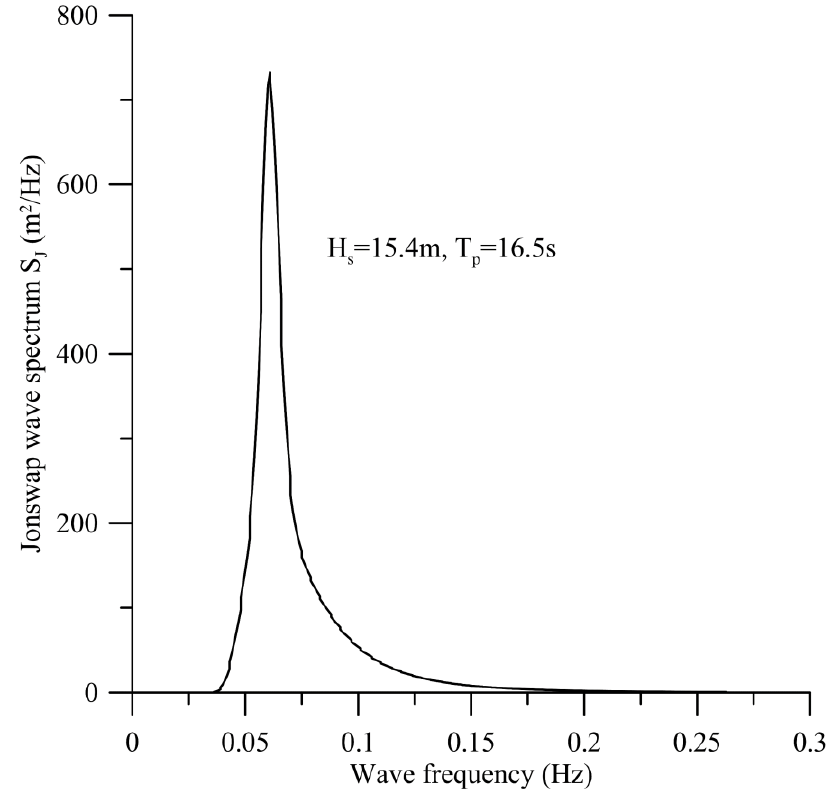
Figure 3. Jonswap wave spectrum.